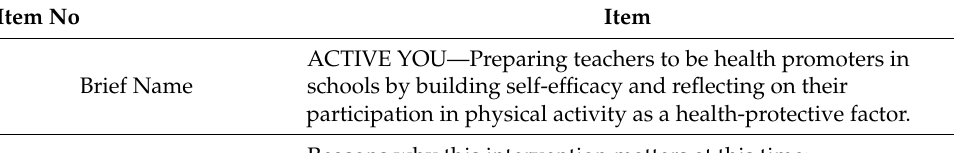
Table 1. TIDieR Intervention